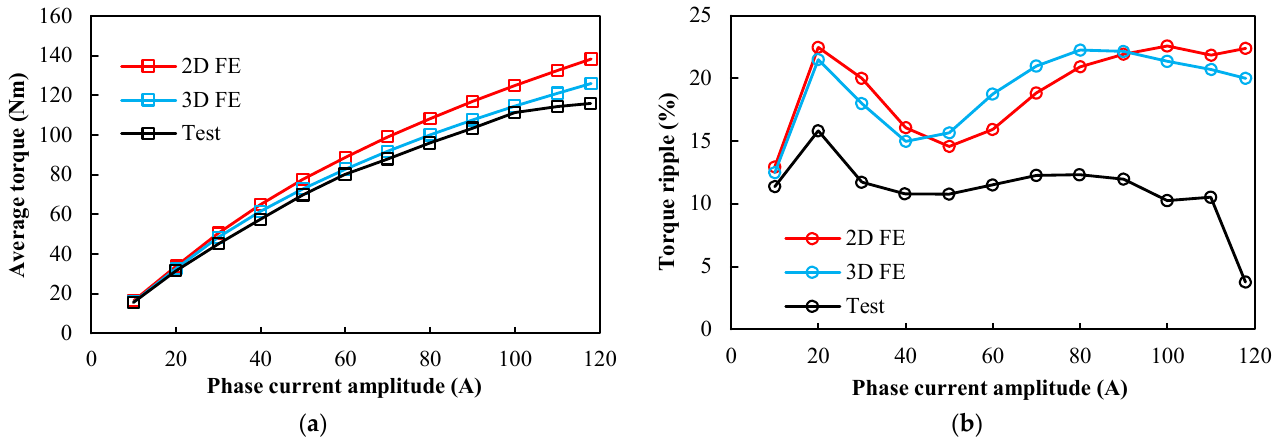
Figure 43. Torque-current amplitude characteristics comparison between FE and measured results with the I d = 0 control strategy: ( a ) Average torque; ( b ) Torque ripple.